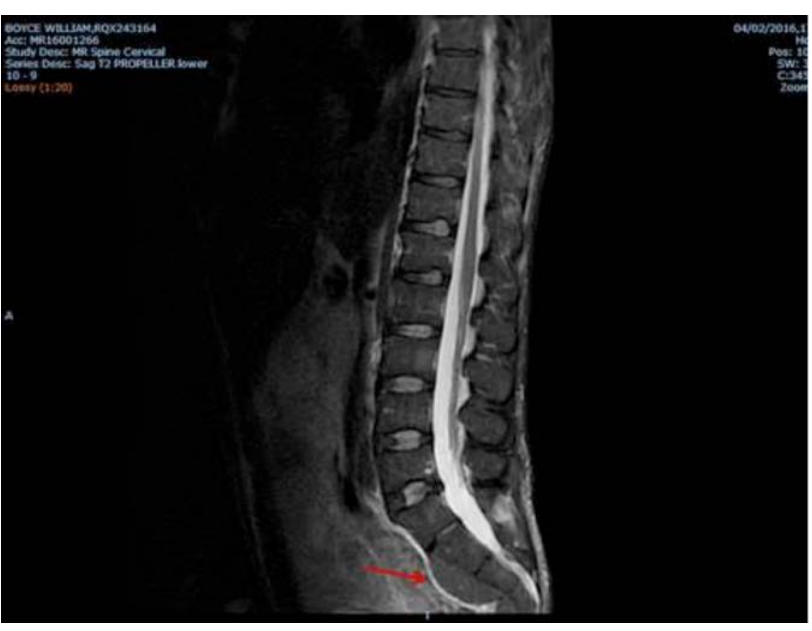
Figure 2. Sacral mass (arrow) due to extramedullary